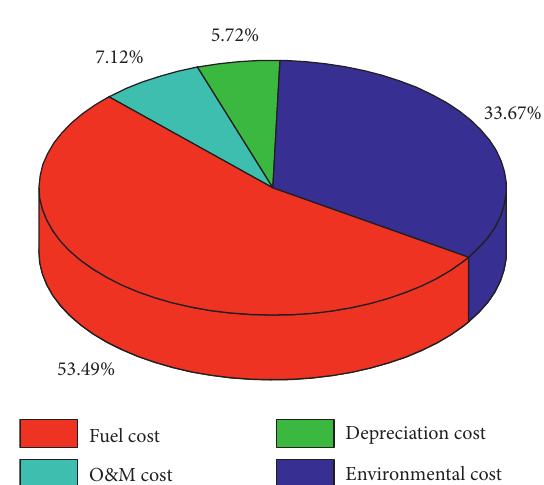
Figure 13: Microgrid cost distribution of the optimal